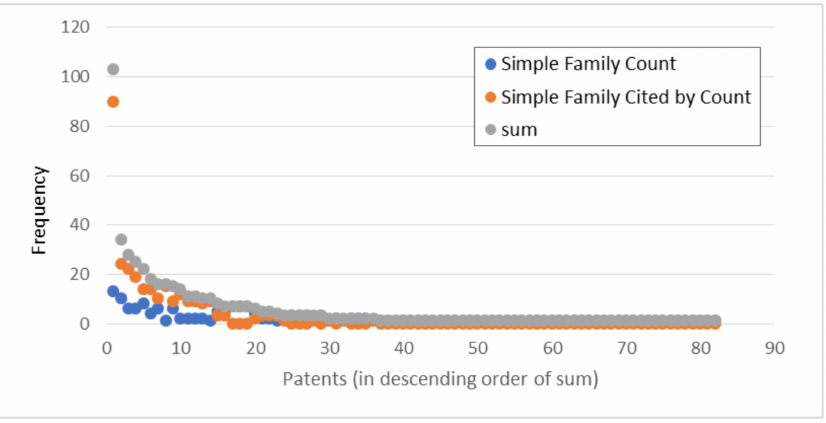
Figure 7. Assessment of the value of patents in the analyzed patent